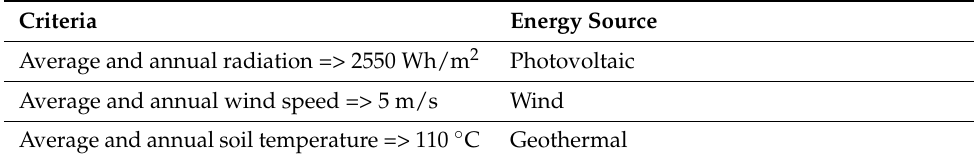
Table 7. Criteria for selecting energy